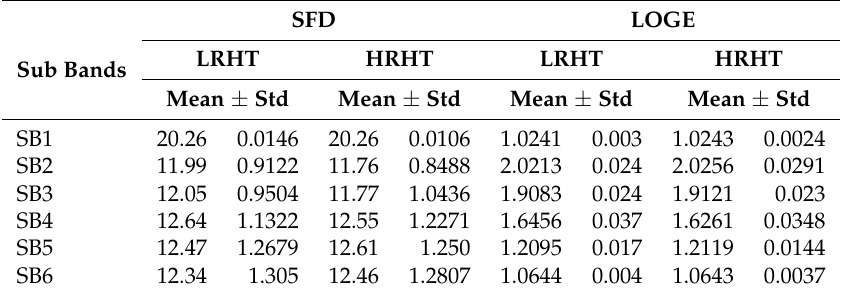
Table 5. Mean and standard deviation for CH2.